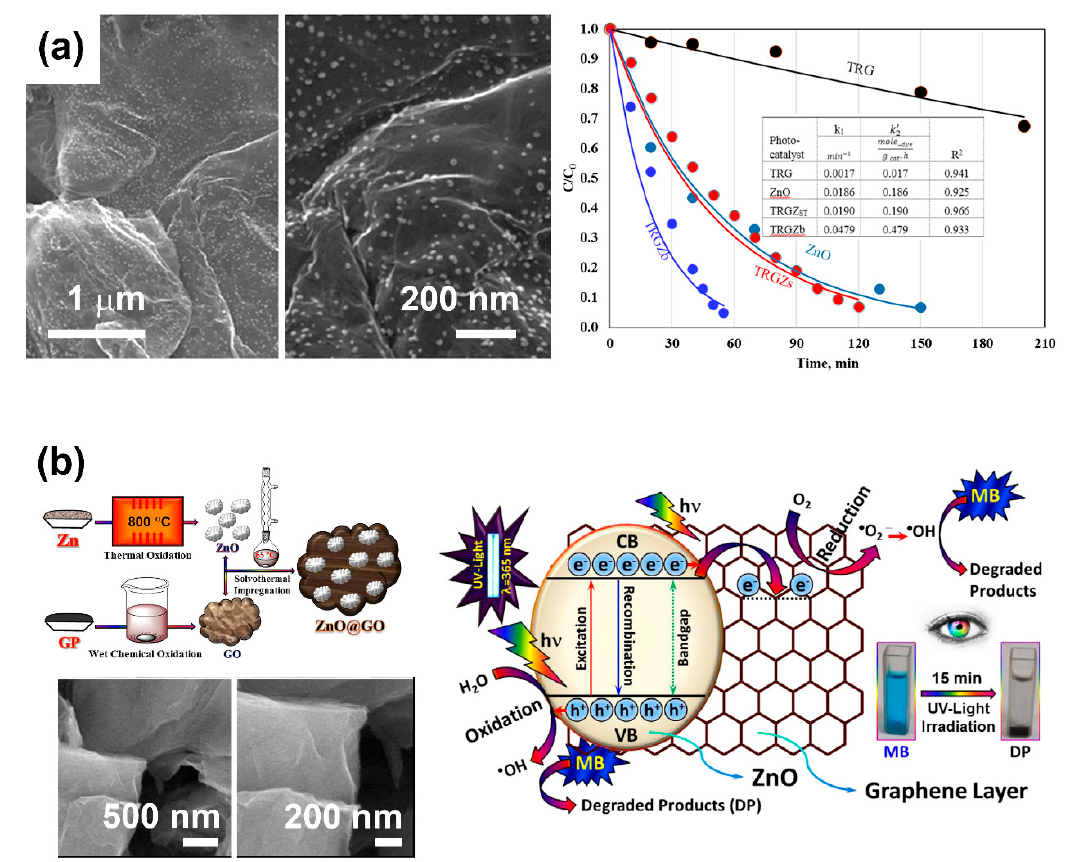
Figure 7. ( a ) Scanning electron microscopy images of ZnO–rGO nanocomposites, showing